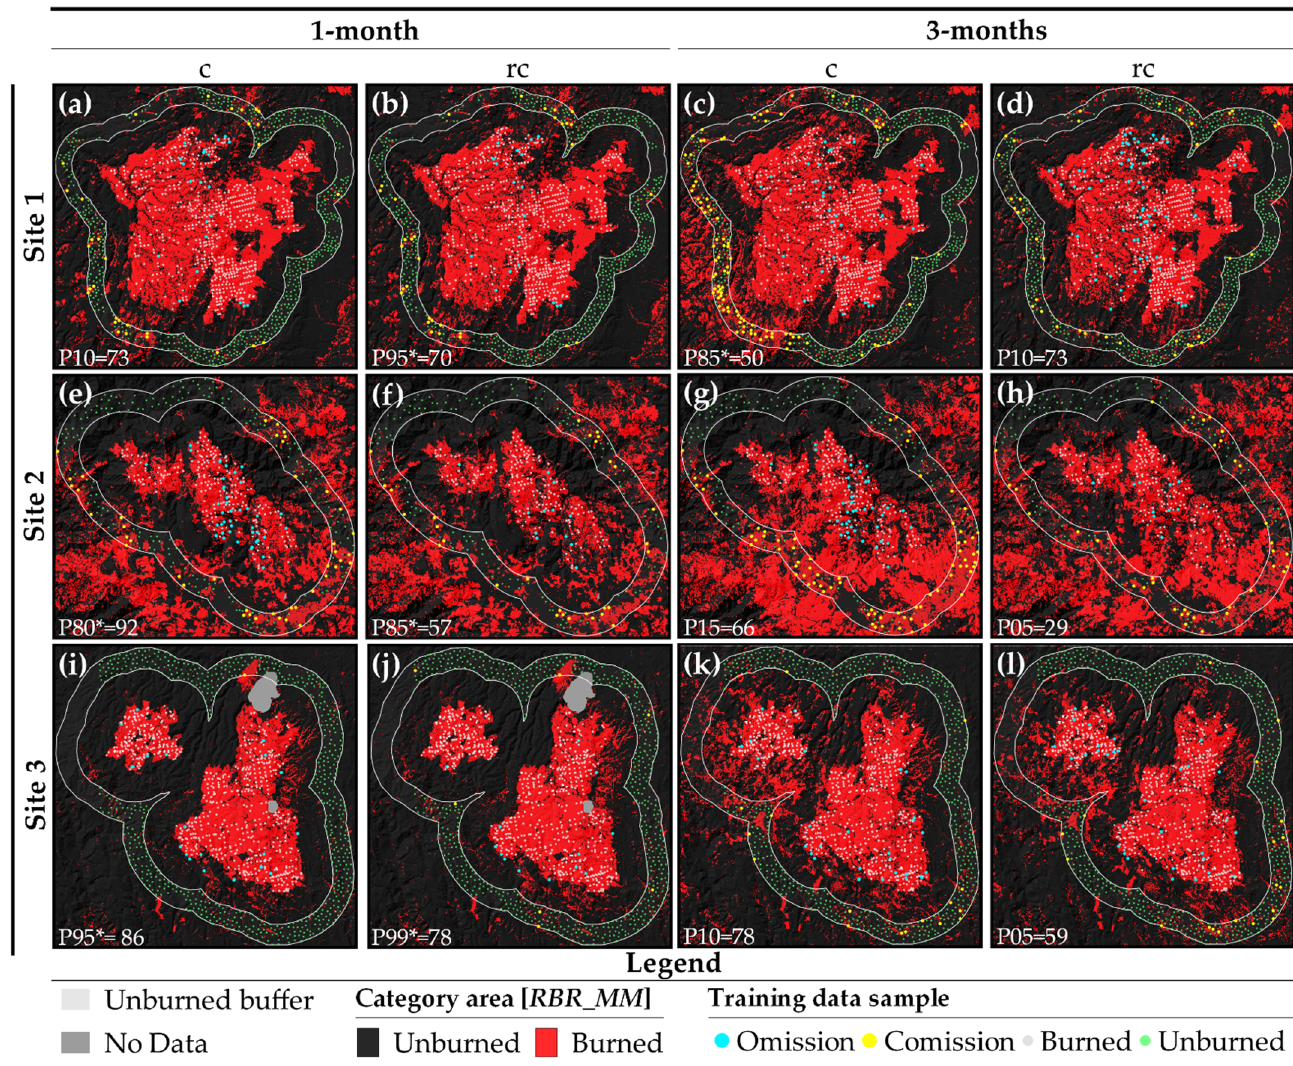
Figure 6. Burned area (shown in red) estimated for site 1 ( a – d ), 2 ( e – h ) and 3 ( i – l ), using the corre- sponding burned area threshold from Table 6, for 1-month (left columns) and 3-month (right columns) MM composites using constant phenology correction c [73] and relative phenological correction rc (proposed in this study). Sampled points for burned areas (active fires) and for unburned areas are shown in gray and green within the active fire perimeter and the unburned buffer, respectively. Omission and commission errors in the sampled burned and unburned point sample are shown in blue and yellow, respectively.